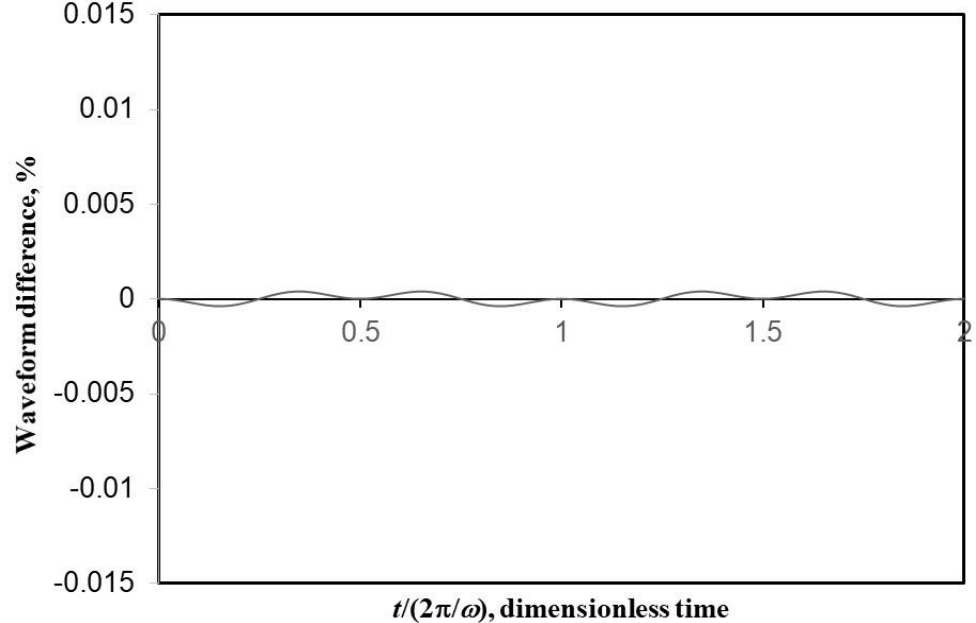
Figure 10. Difference between elliptic cosine and simple cosine ( c/a = 0.5, k = 5, w/w o = 3, ξ = 0.02, single cavity, linear solution).